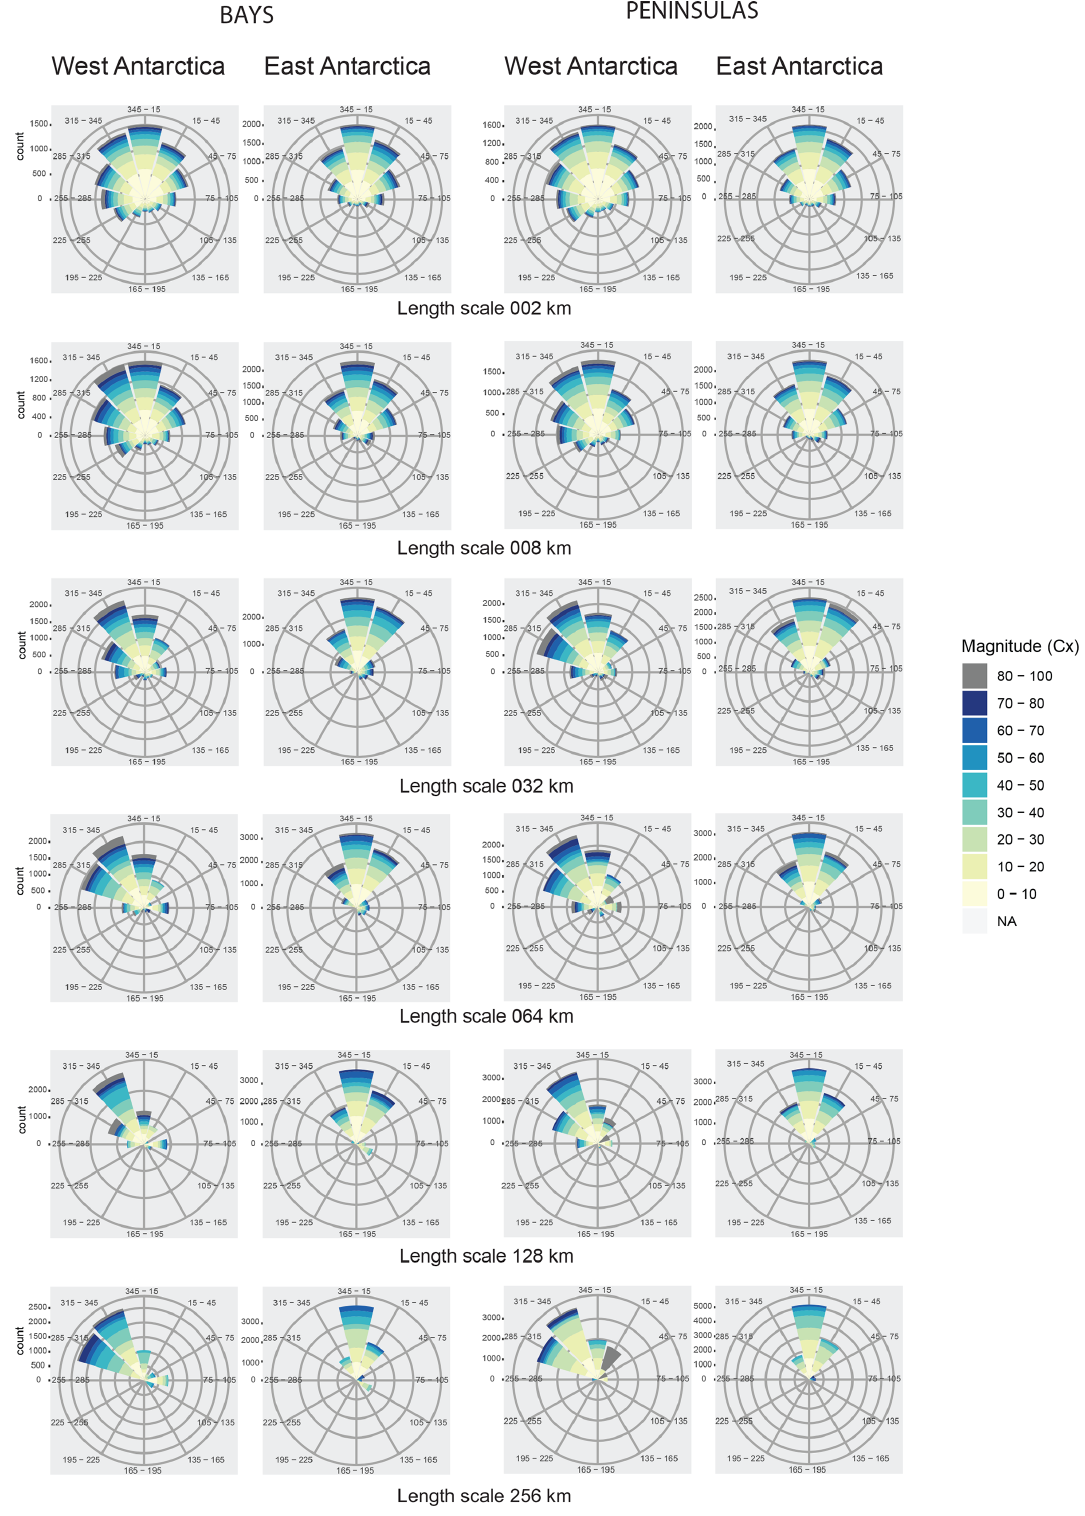
Figure 4. Rose plots comparing the distribution of complexity (magnitude and direction) between western and eastern Antarctica. Six length scales are represented: 2, 8, 32 64, 128, and 256km. The directions are relative to offshore.